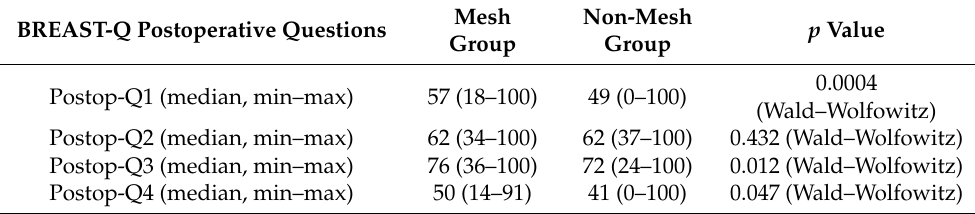
Table 3. BREAST-Q postoperative results.